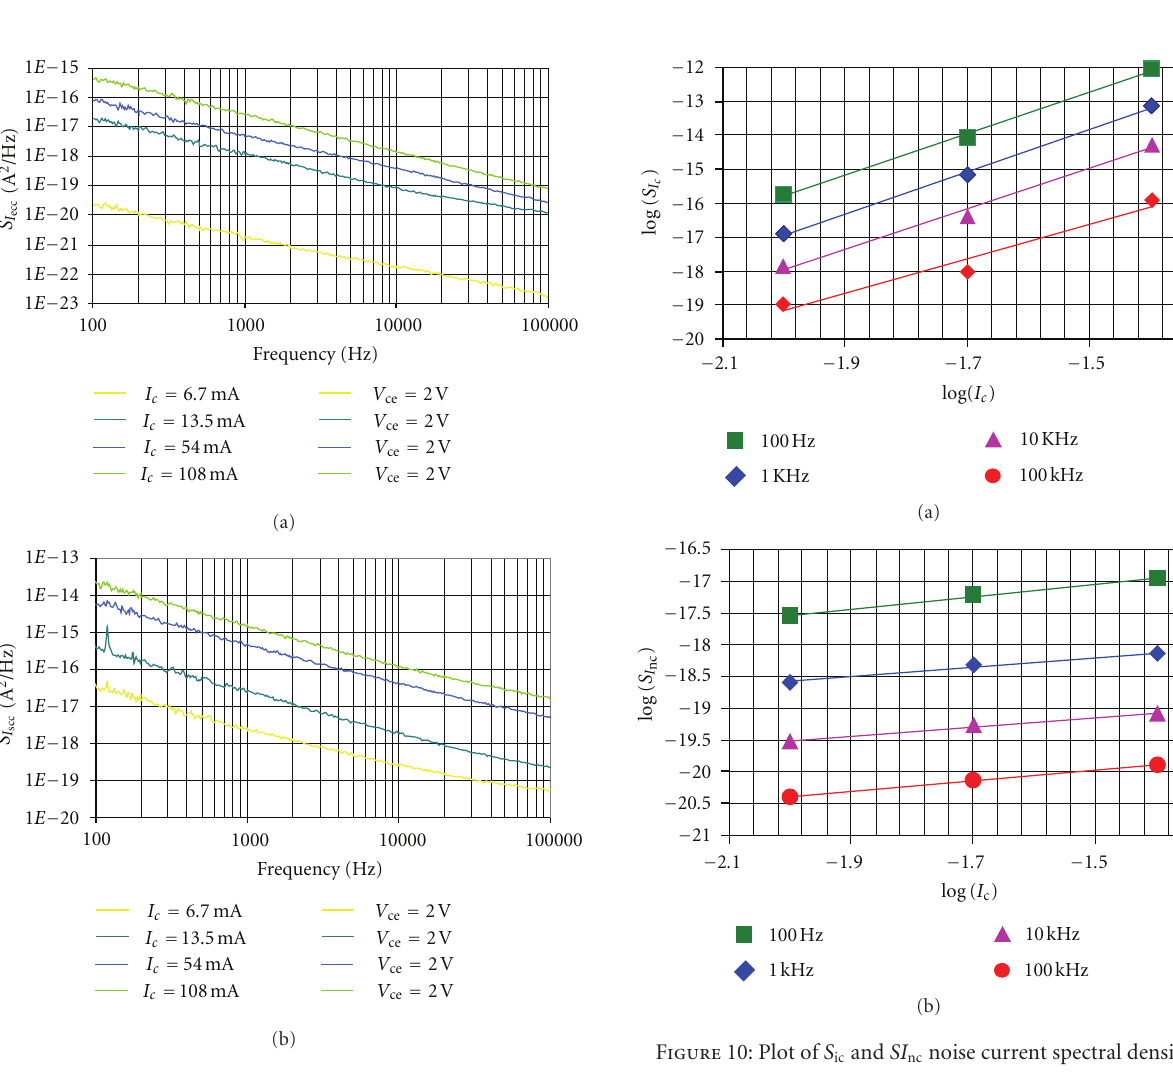
Figure 9: Spectral densities plot of the short-circuit noise current at transistor access for collector currents I c